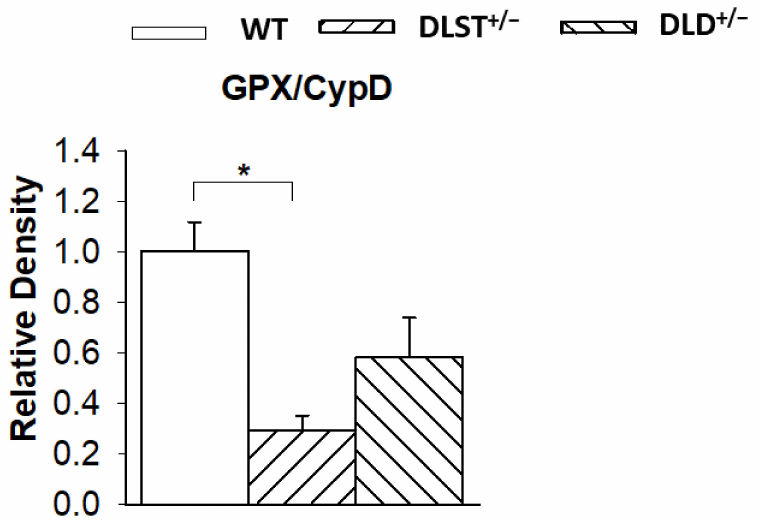
Figure 9. Western blot analysis and relative density changes for glutathione peroxidase (GPX), normalized for cyclophilin D (CypD) protein expression, in brain mitochondria isolated from the wild-type and KGDHc-subunit-deficient mice. White bars: wild-type (WT); bars with left diagonal stripes: dihydrolipoyl succinyltransferase mutation (DLST +/ − ); bars with right diagonal stripes: dihydrolipoyl dehydrogenase mutation (DLD +/ − ). Results are expressed as means of the relative densities ± S.E.M. ( N = 3–4). Statistically significant differences are indicated by asterisks; * p <